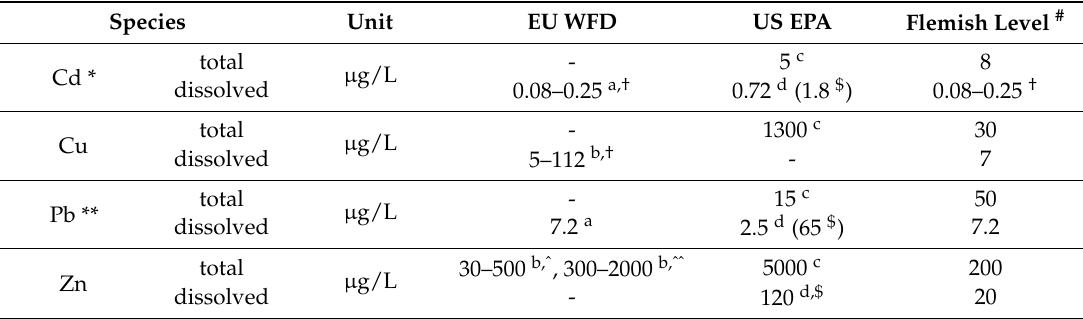
Table 1. Concentration limits imposed by different